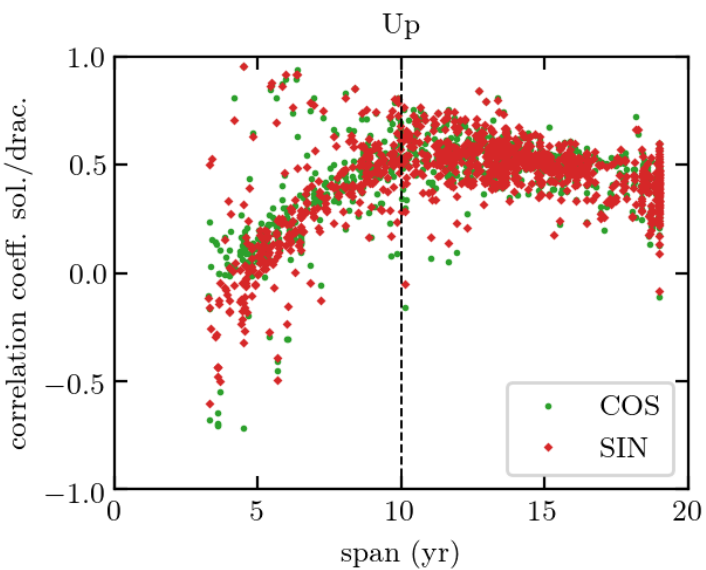
Figure 12. Coefficient of correlation between annual solar wave and draconitic first harmonic for cosine and sine terms of tiasd as a function of the length of the time